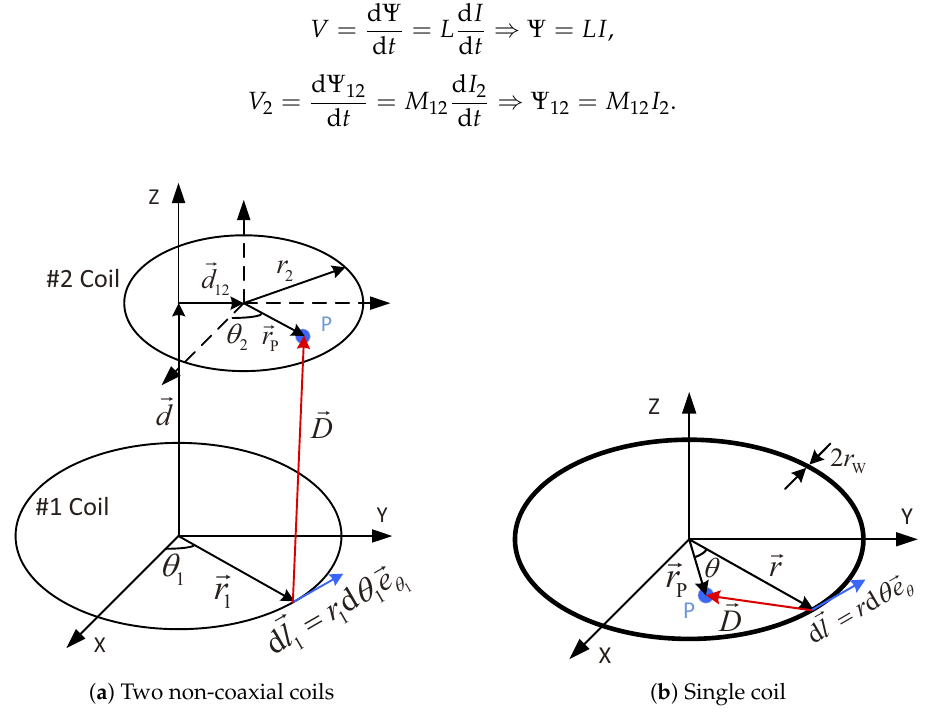
Figure A1. ( a ) The model for calculating mutual inductance of two non-coaxial coils with a single loop; ( b ) the model for calculating the self-inductance and self of a coil with a single